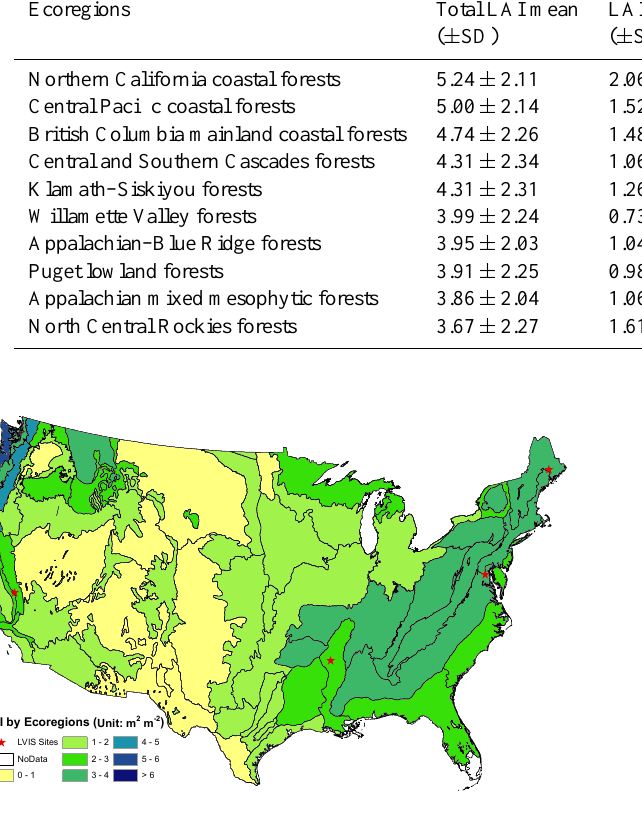
Figure 5. GLAS LAI distributions by ecoregion. All LVIS sites are marked with red stars.